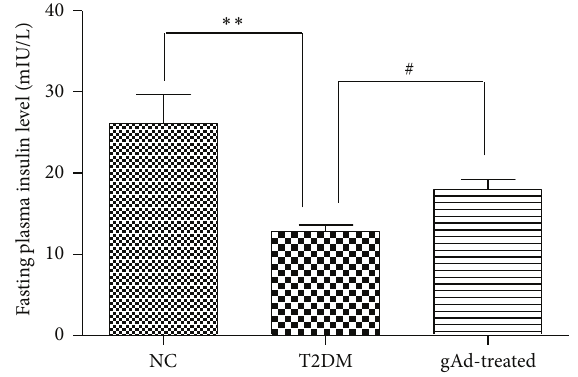
Figure 2: Comparison of plasma insulin levels of all groups. ∗∗ 𝑃 < 0.01 compared with NC group, # 𝑃 < 0.05 compared with T2DM